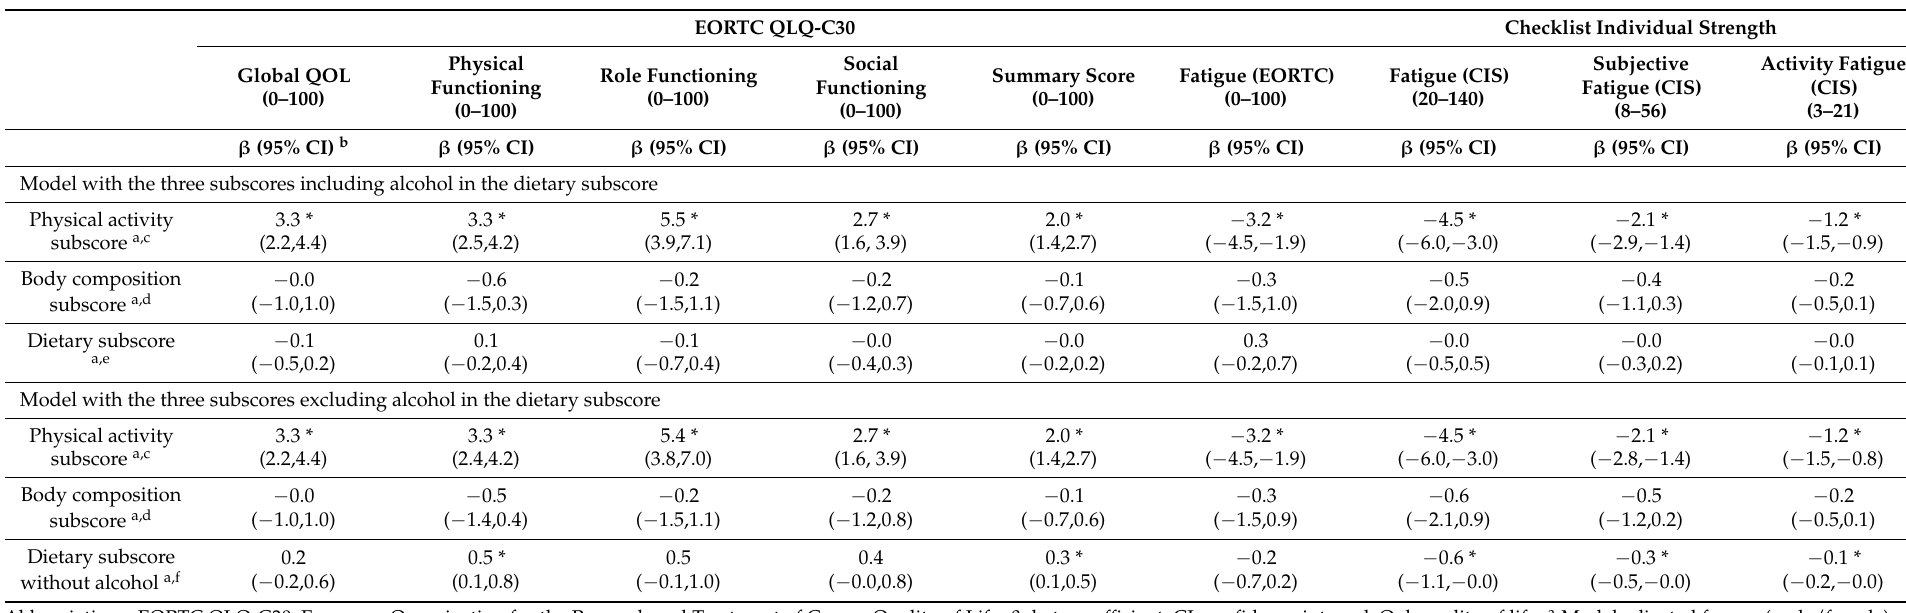
Table 4. Linear mixed models between the physical activity subscore, body composition subscore, and dietary subscore (with and without alcohol), all in one model, in relation to health-related quality of life, and